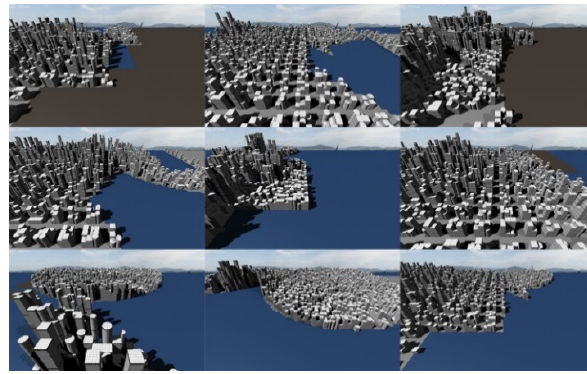
Figure 9. Generation 40 of an IGA run